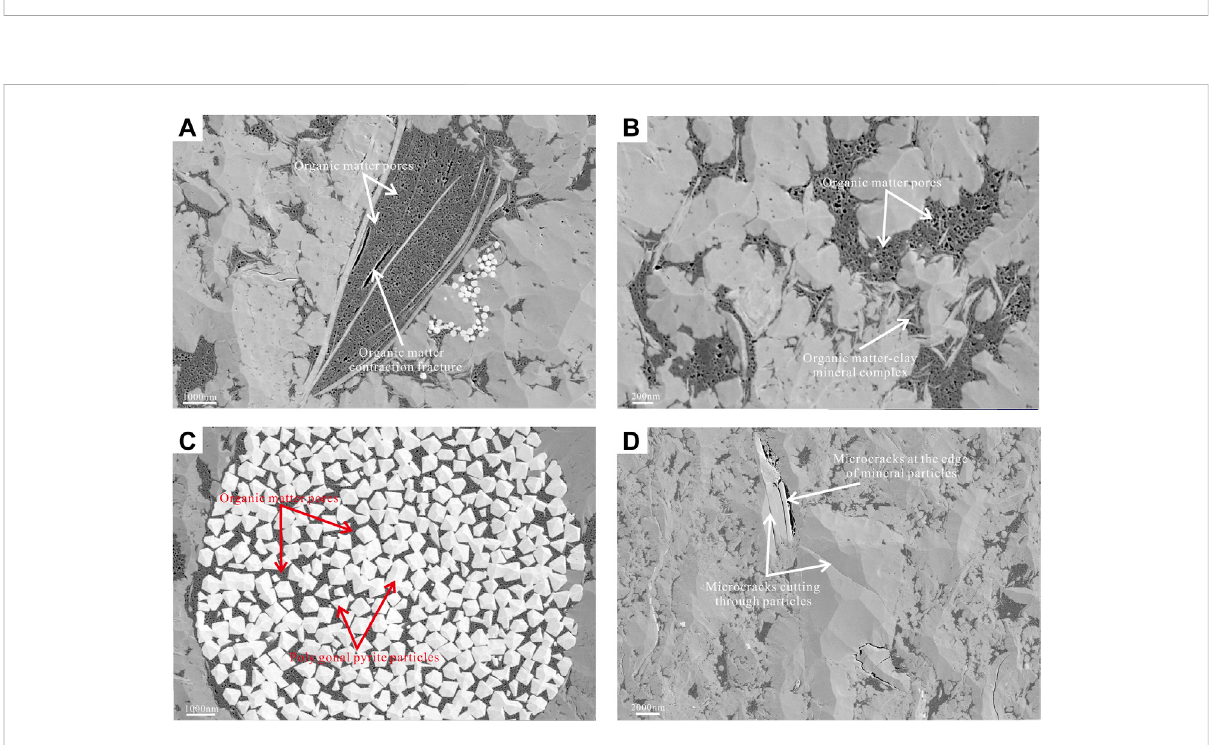
FIGURE 3 FE-SEM images of a shale from the Longmaxi Formation (TOC =5.05%, Sample 9) [ (A) organic shrinkage cracks and organic pores; (B) organic- clay mineral complexes and organic pores; (C) organic – pyrite complex and organic pores; (D) mineral grain edge seams and microcracks that cut through